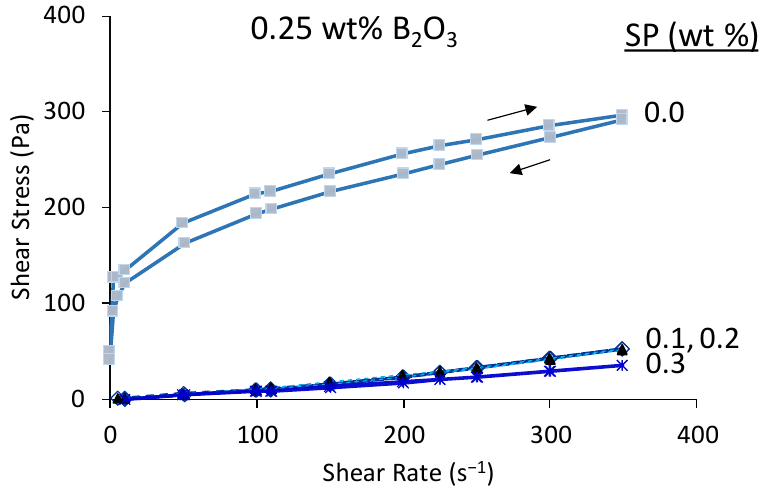
Figure 2. Flow curves of st-BYF with 0.25 wt % of B 2 O 3 externally added as borax with w/c = 0.40 and different superplasticiser (SP) contents.